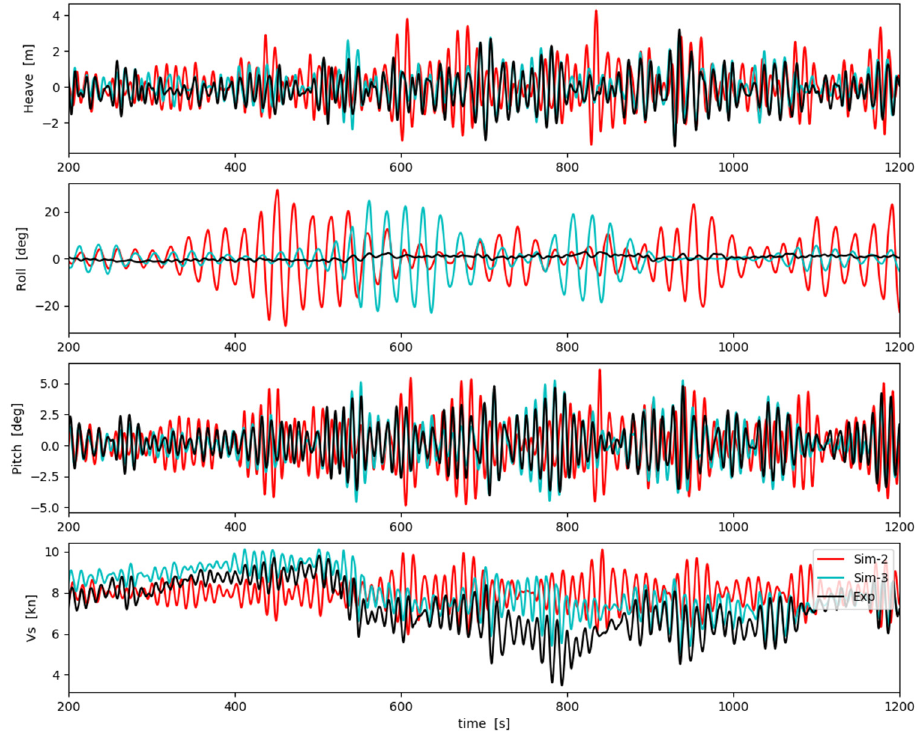
Figure 10. Results of deterministic comparison of a parametric roll event in irregular head seas (Jonswap spectrum, Hs = 8.0 m, Tp = 13.5 s, γ = 3.3), vs. ≈ 8 kn.